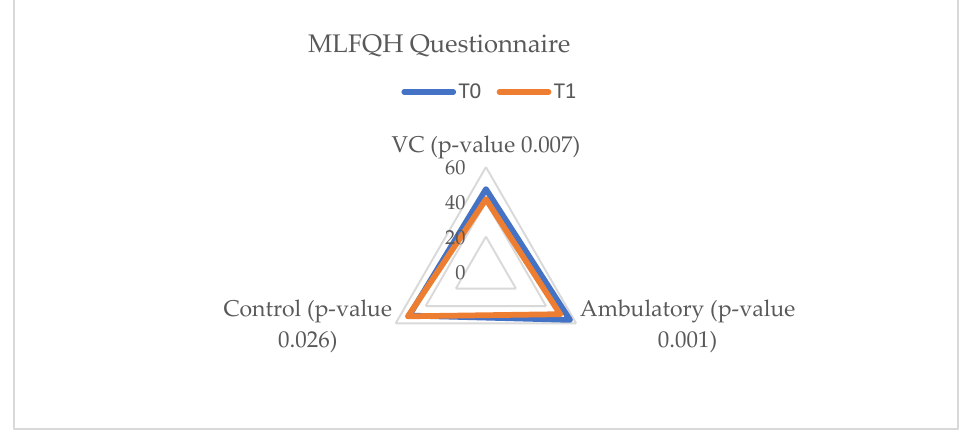
Figure 3. Minnesota questionnaire results. MLFQH = Minnesota living with heart failure questionnaire; EG = experimental group; AG = ambulatory group; CG = control group; T 0 = before the rehabilitation period; T 1 = after the rehabilitation period.